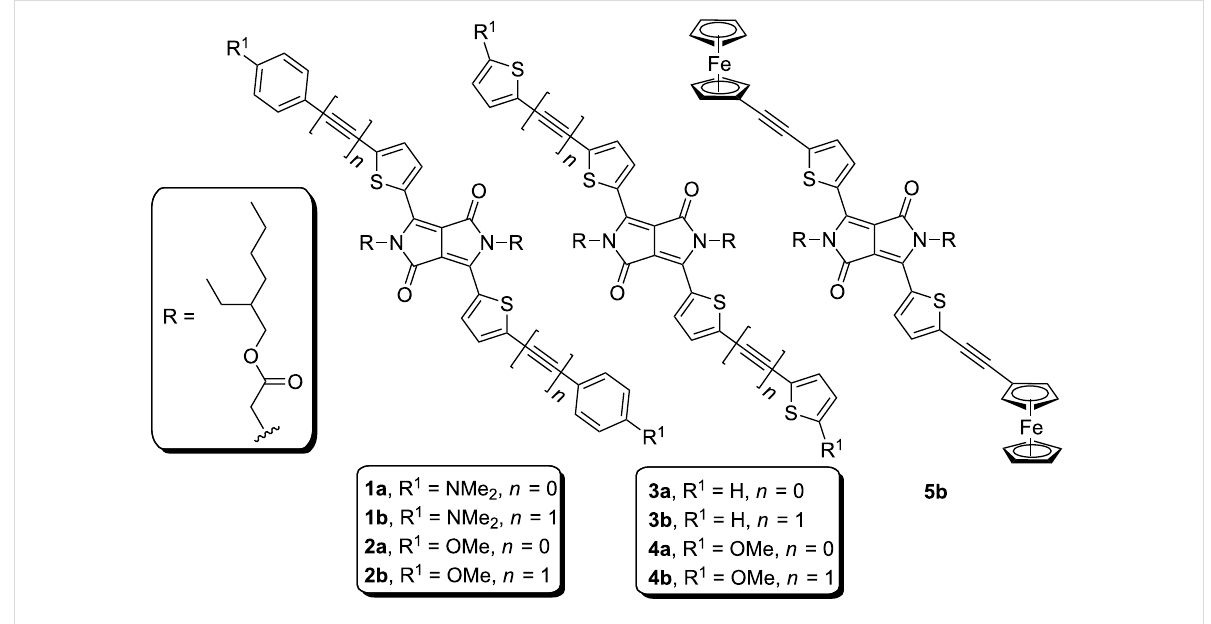
Figure 1: General structure of investigated DPP derivatives 1 – 5